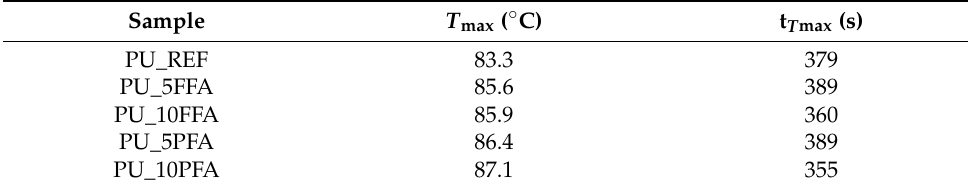
Table 1. Characteristic parameters of the foaming process.